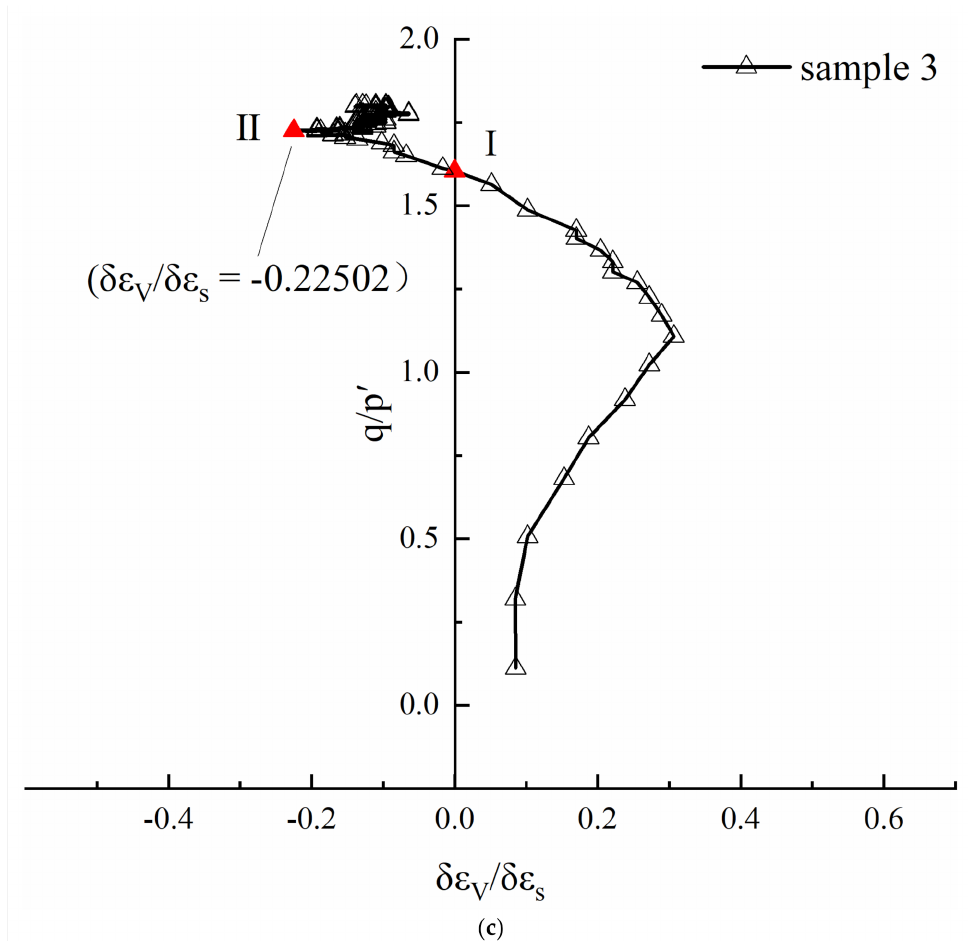
Figure 6. Stress-dilatancy relationship of hydrate-bearing